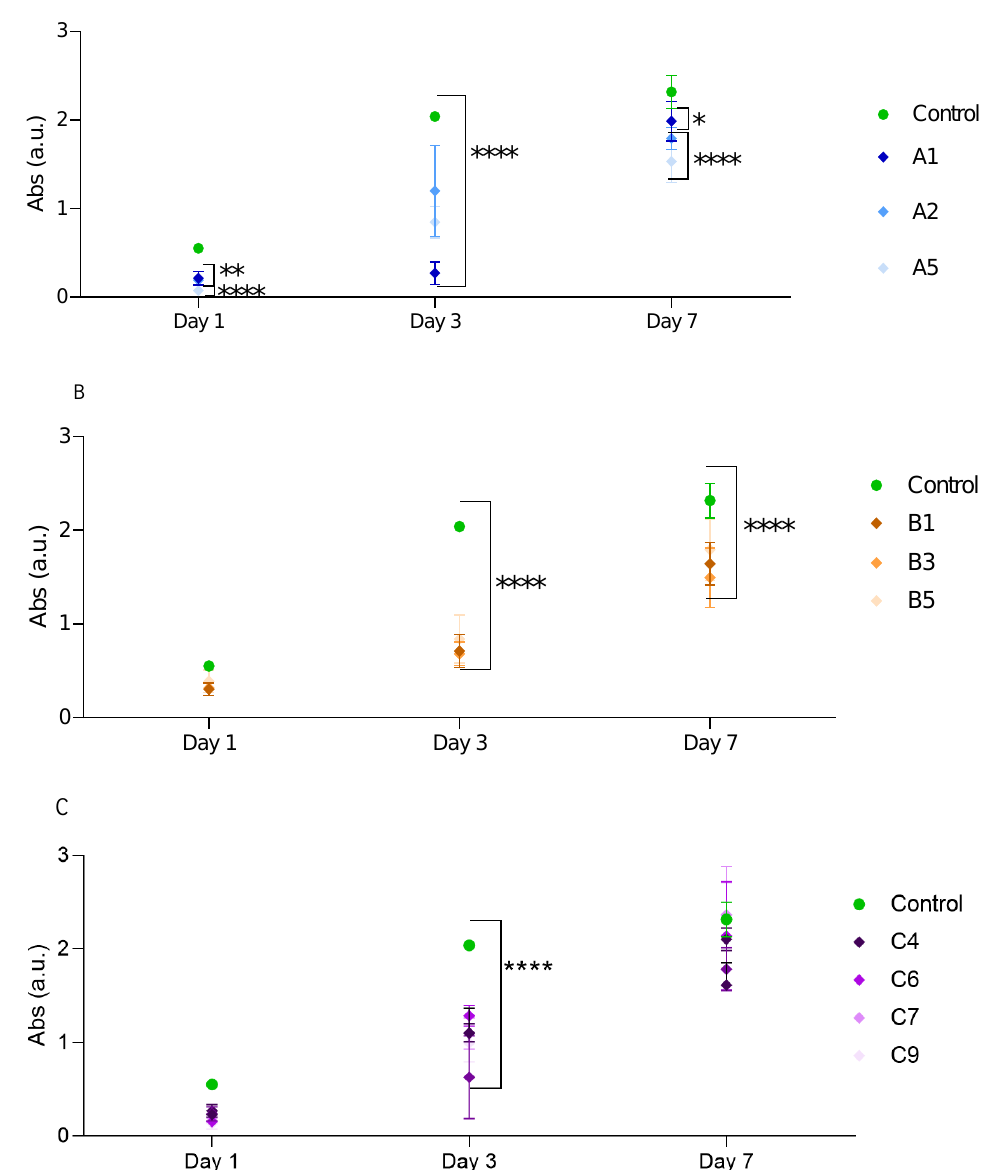
Figure 10. Cell density of ( A ) SF/HA; ( B ) curcumin-loaded SF; ( C ) curcumin-loaded SF/HA. Data are expressed as percentage of cell viability ± SD vs. concentration. * Indicates p < 0.05, ** indicates p < 0.01, and **** indicates p < 0.0001, compared to control.